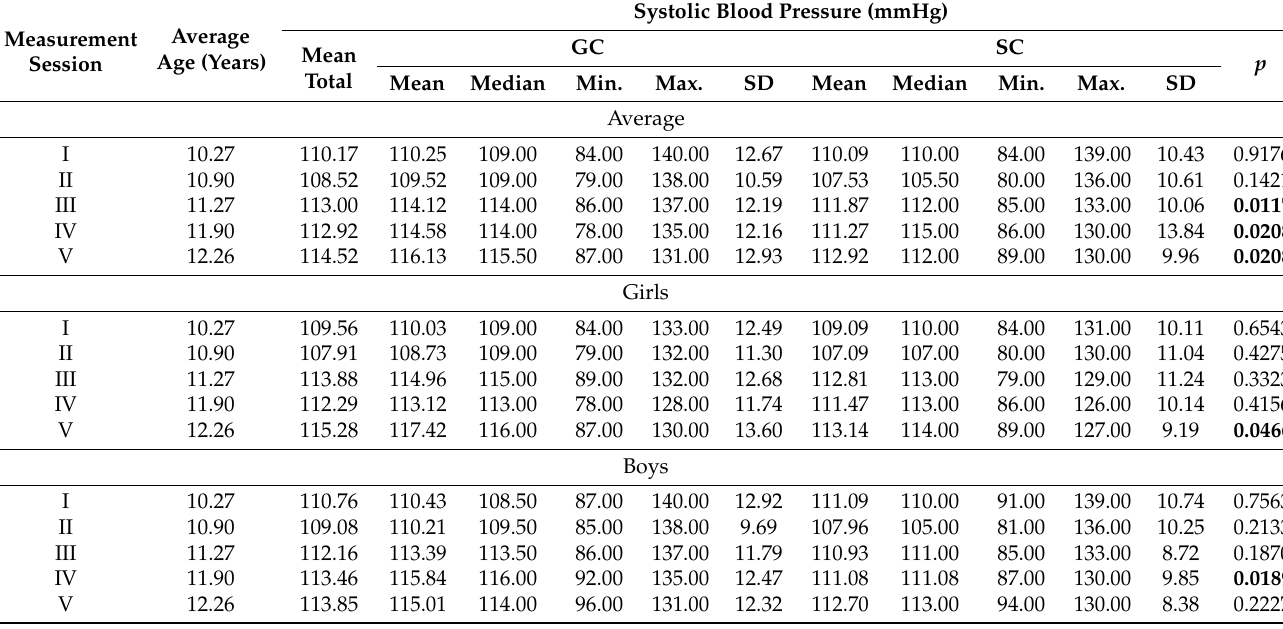
Table 1. The mean systolic blood pressure in children during the course of the study (mmHg).